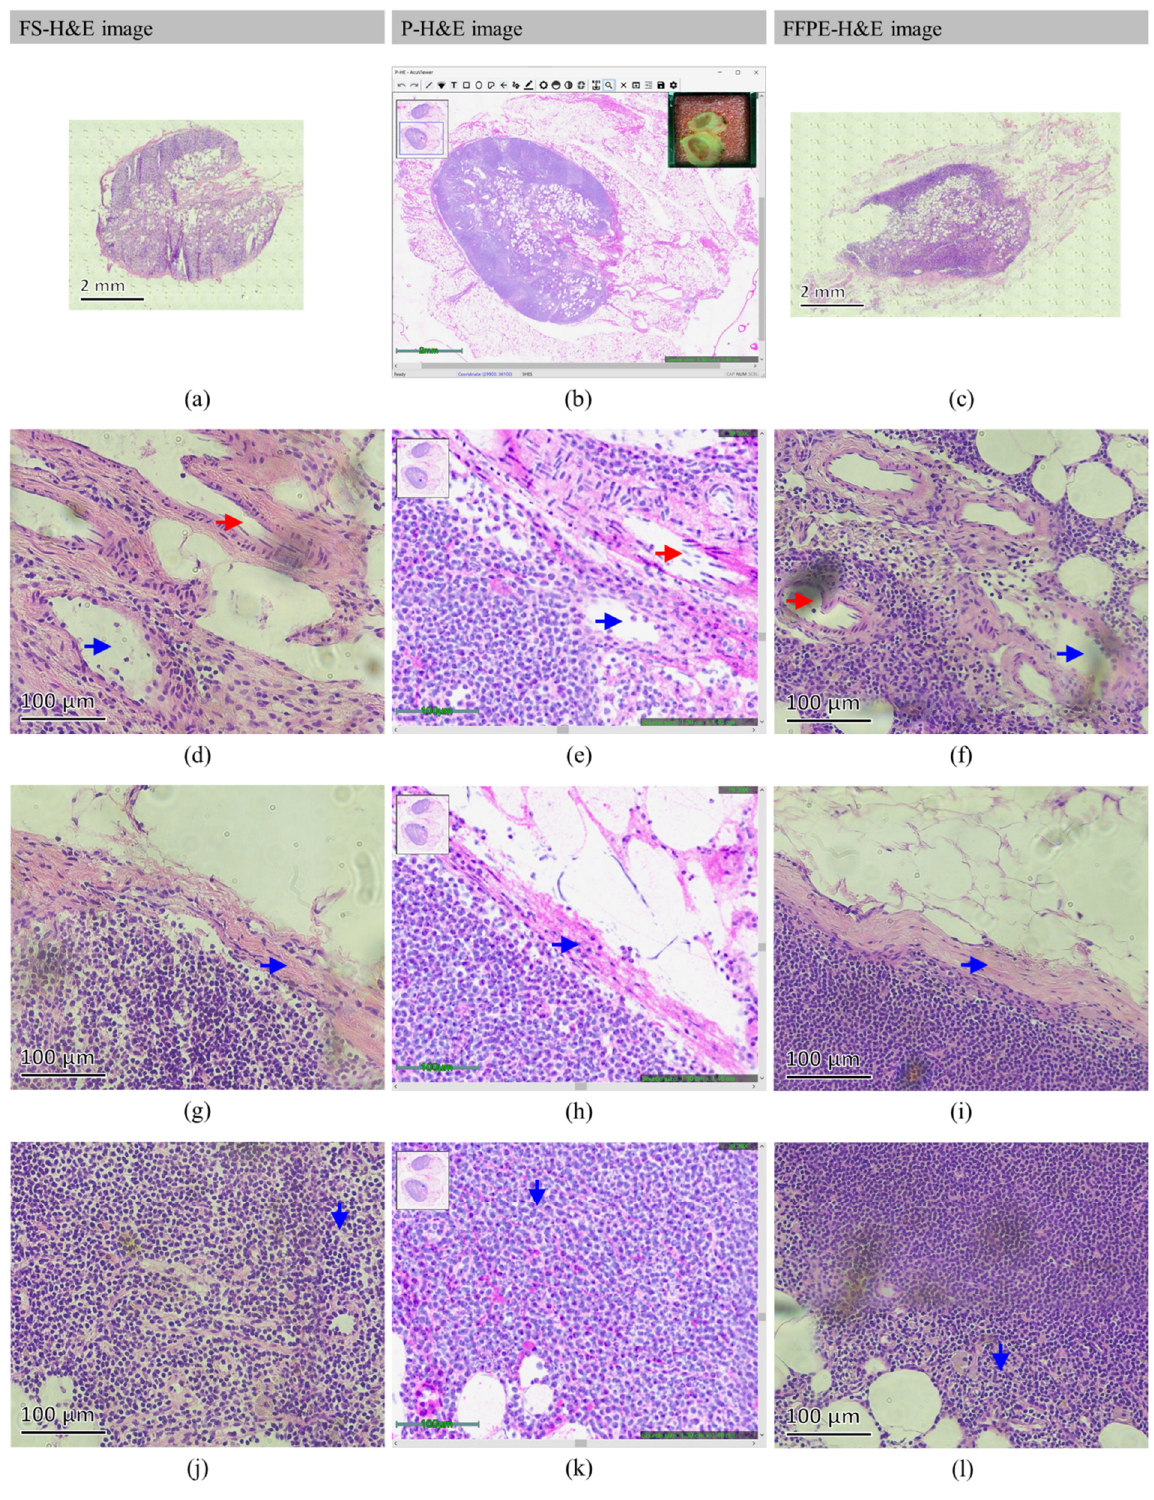
Figure 4. Comparison of FS-H&E, p-H&E, and FFPE-H&E images acquired from the same normal SLN #A of patient #6. ( a – c ) present the images of the lower specimen indicated in the true-tissue snapshot (top-right inset) of ( b ); the top-left inset of ( b ) is the browsing navigator. In ( d – f ), red and blue arrows indicate arterioles and veins, respectively. Blue arrows in ( g – i ) indicate the capsule between the fat and cortex. Blue arrows in ( j – l ) represent the lymphatic vessels in the cortex region.